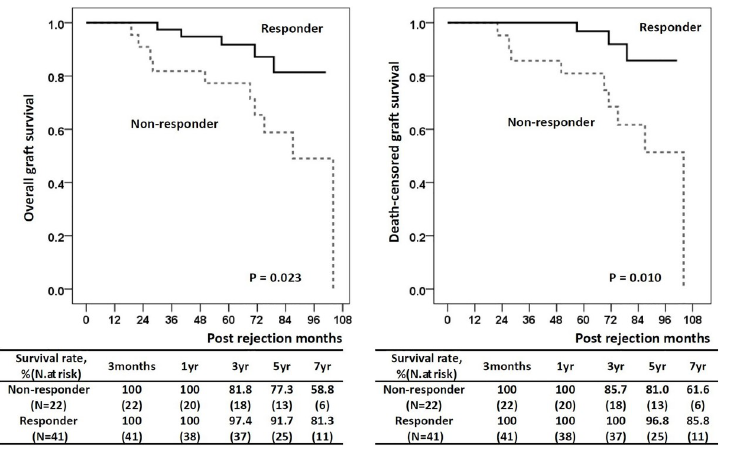
Fig 3. Overall and death-censored graft survival rate after rejection treatment.